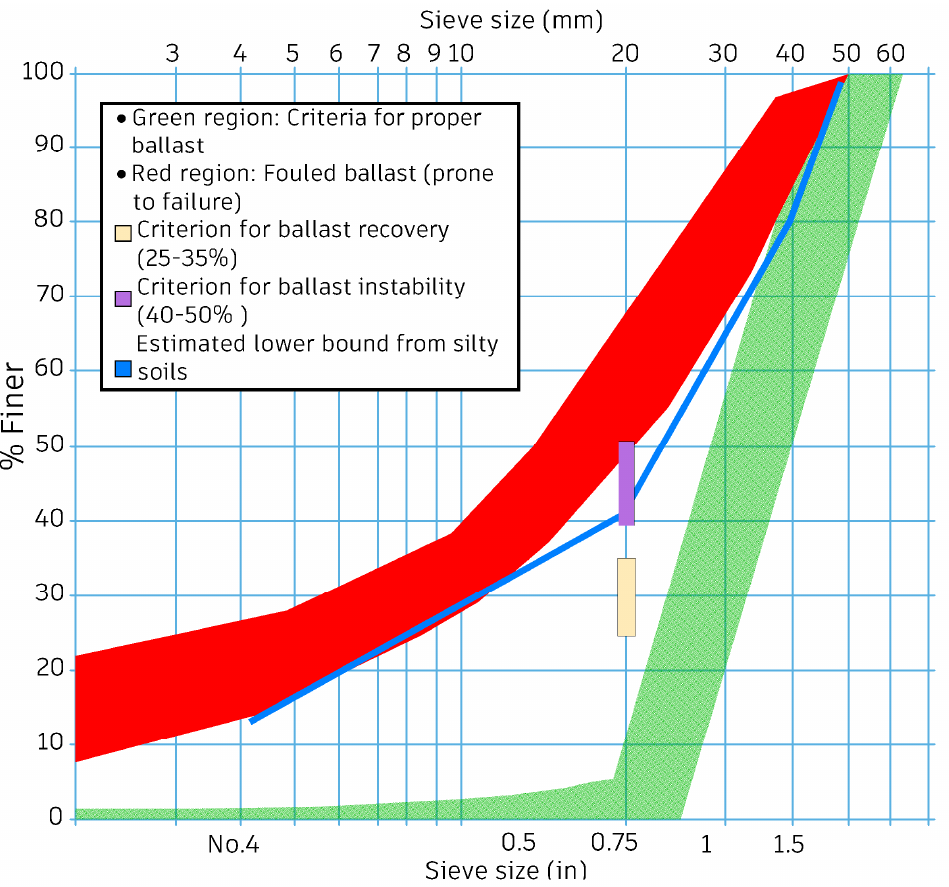
Figure 6. Ballast gradation chart [5].